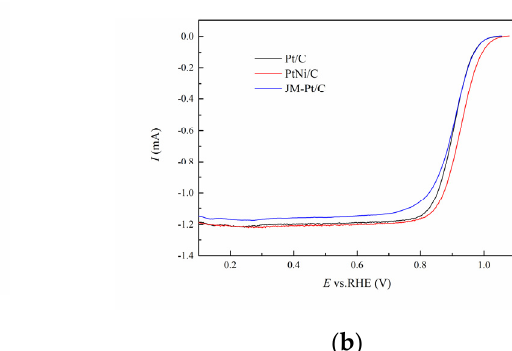
Figure 4. Energy dispersion X-ray spectrogram of PtNi/C.